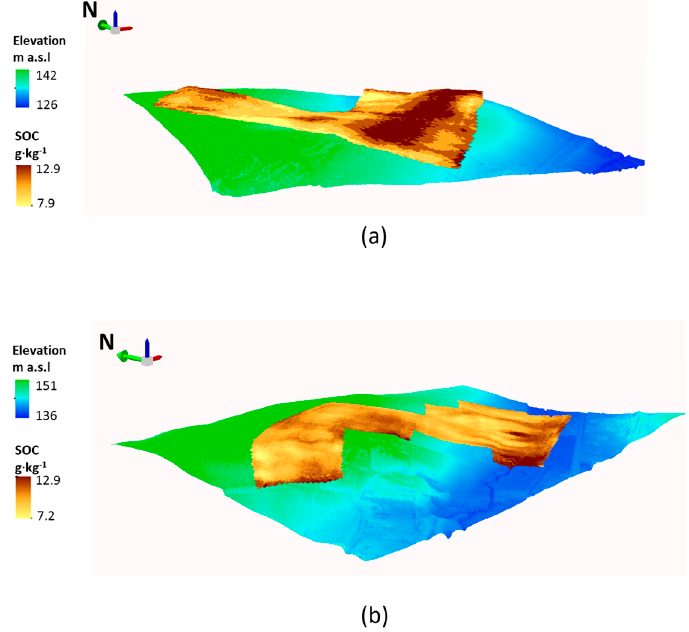
Figure 8. Soil organic carbon maps of the field 7 ( a ) and another bare field ( b ) obtained by the bottom-up approach in the loam belt area laid on top of the digital terrain model (DTM) of the Wallonia region with a 1 m resolution.